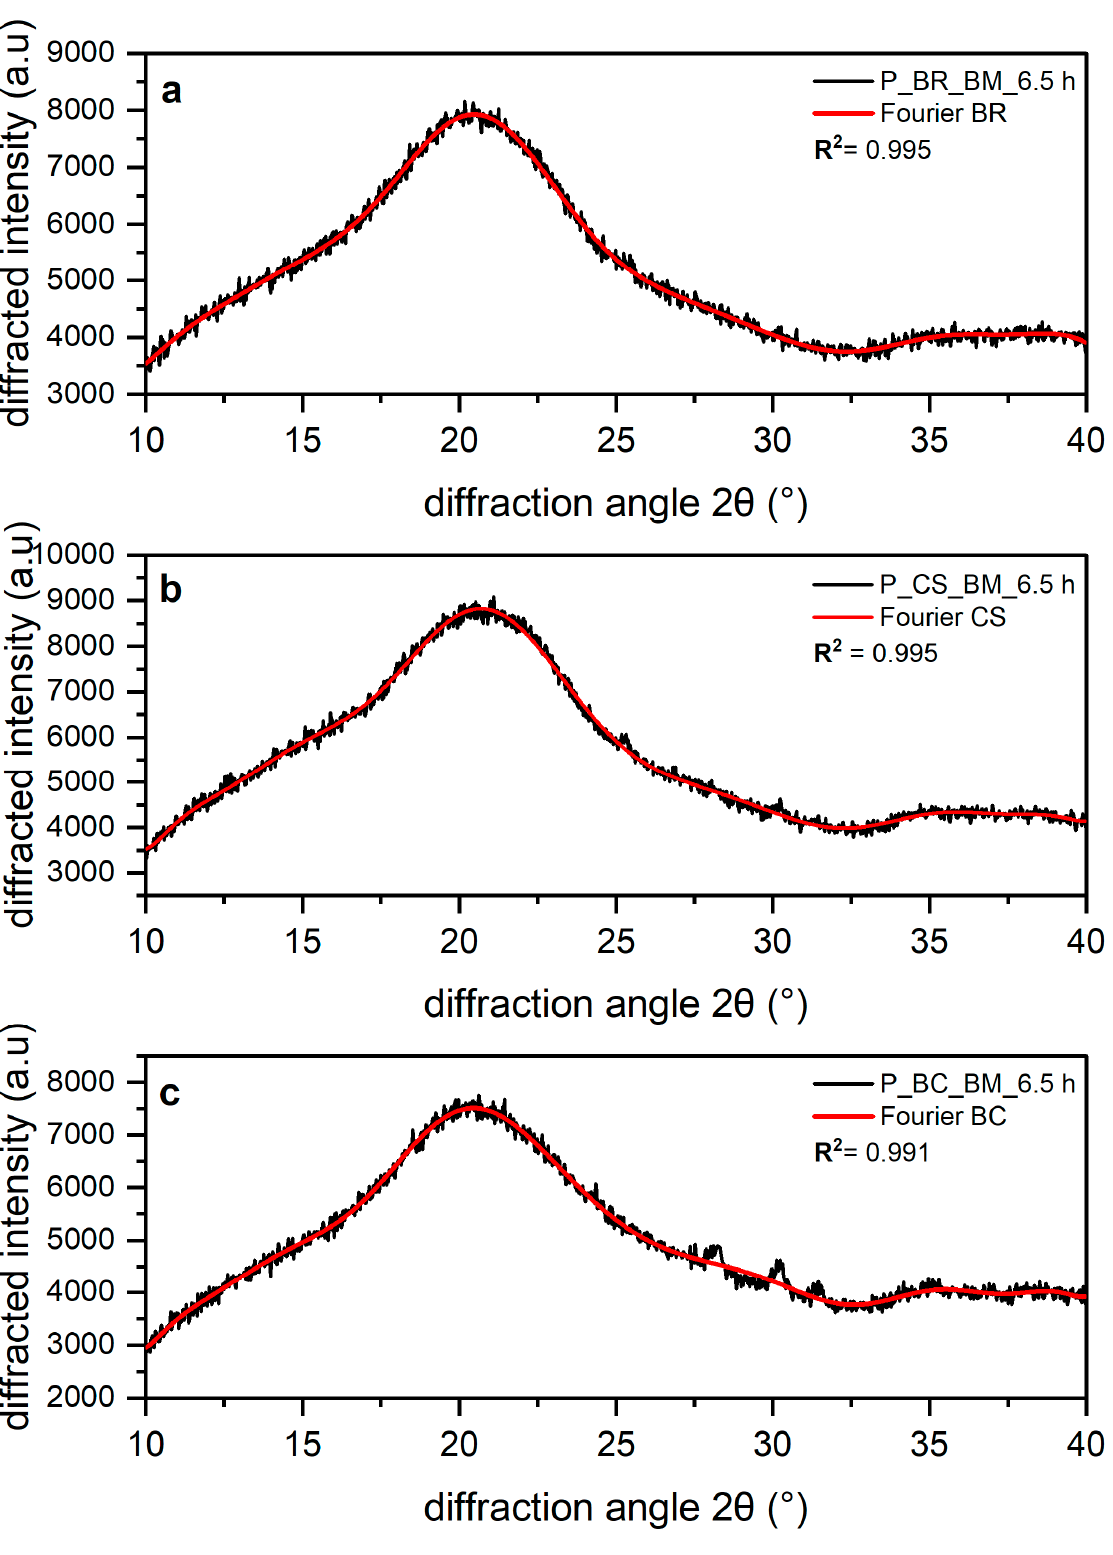
Figure 4. ( a ) Amorphous banana rachis (BR), ( b ) commercial sample (CS), and ( c ) bacterial cellulose (BC) XRD. The black line corresponds to the experimental result and the red line to data fit using the Fourier function.